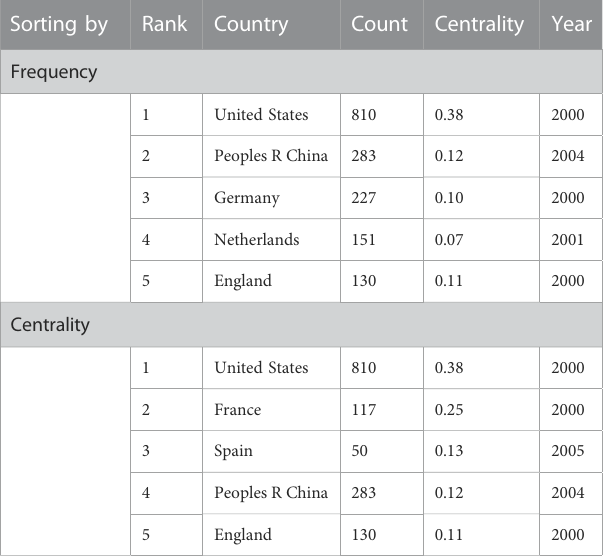
TABLE 1 Top fi ve countries/regions that contributed to publications on molecular imaging research in AS. Sorting by